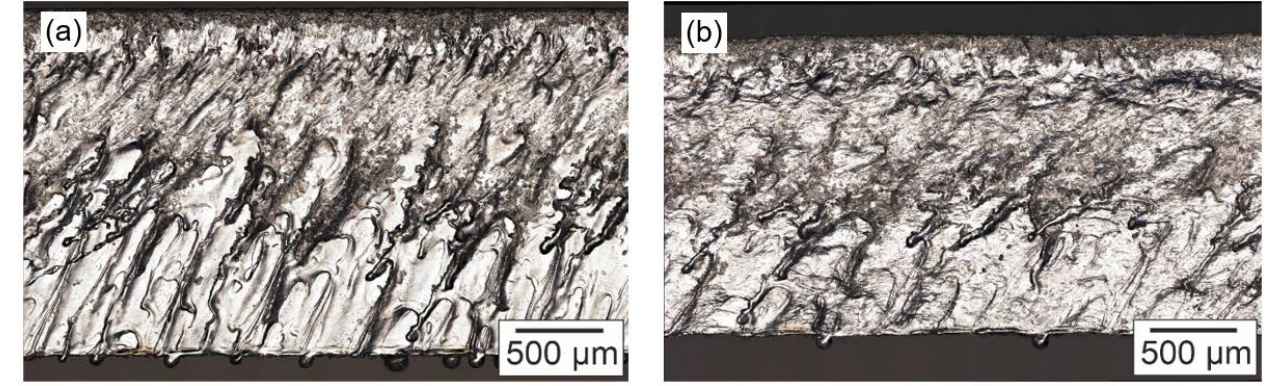
Figure 5. Top view of the laser-cut edge. ( a ) As cut, ( b ) Pre- deformed (ε = 28